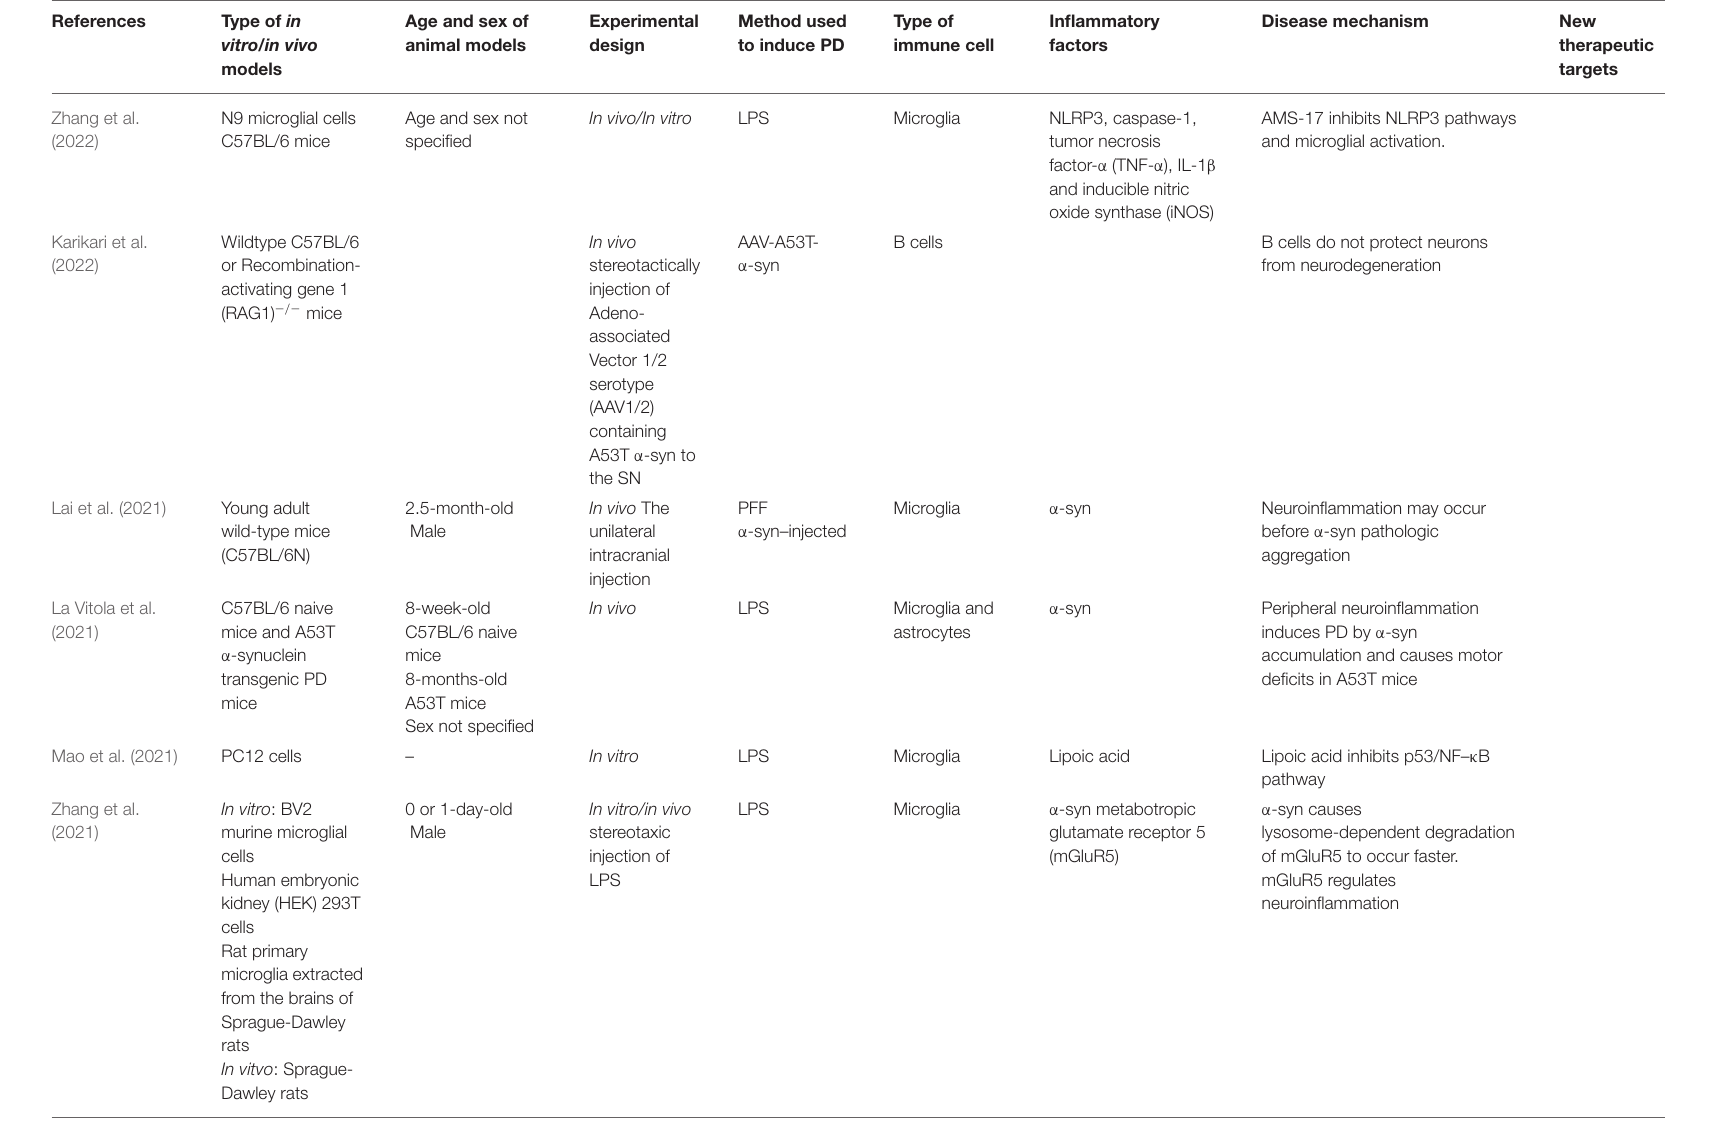
TABLE 1 | A rapid review of articles